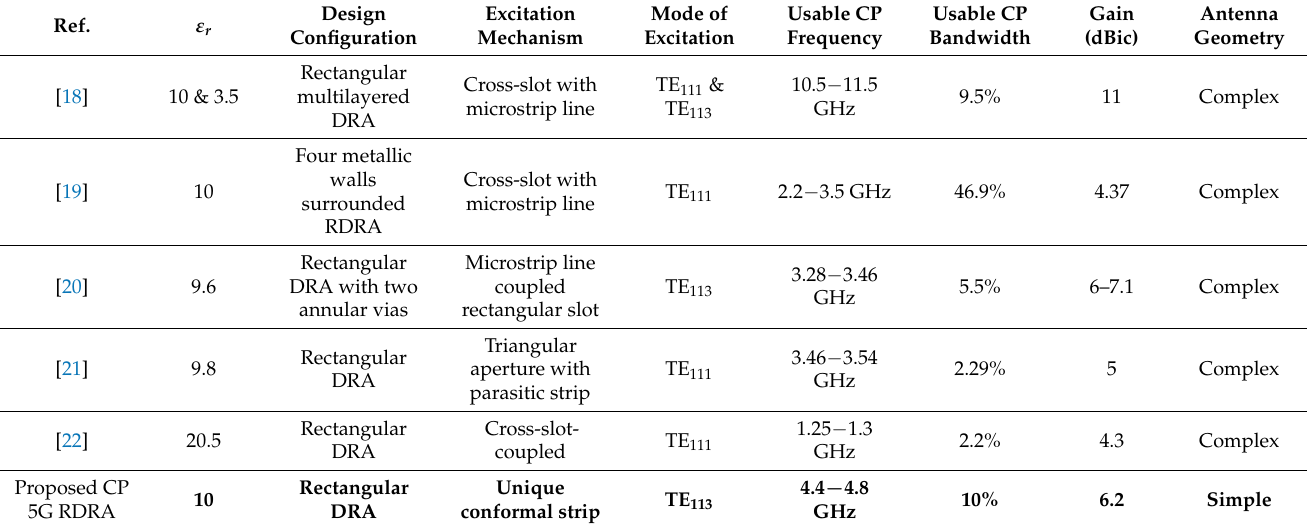
Table 4. Comparison between proposed CP 5G RDRA with recently reported RDRAs in literature.